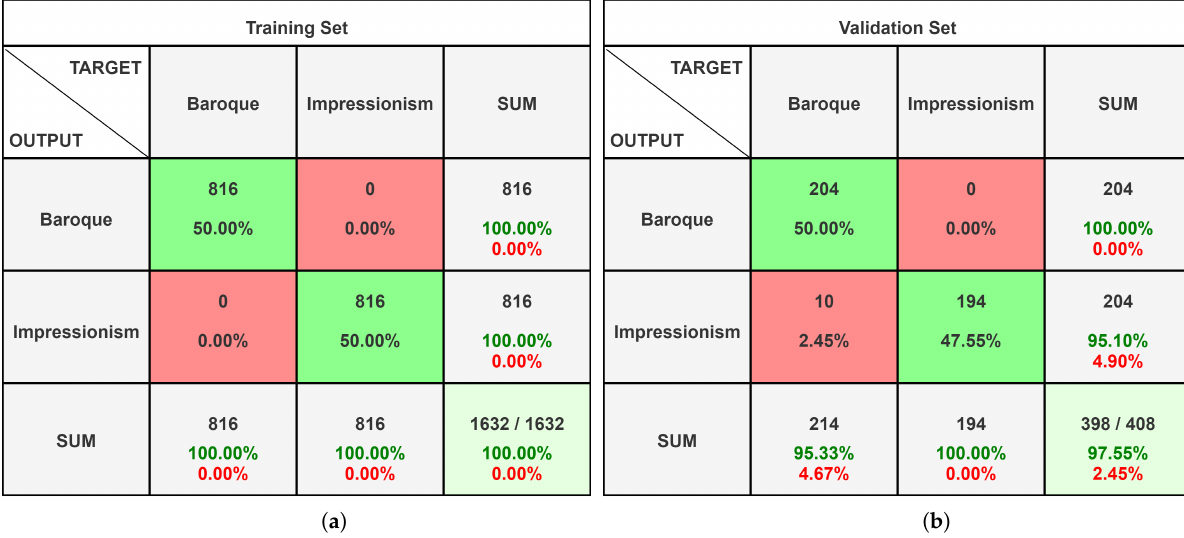
Figure 5. Confusion matrices of the painting dataset analysed on Alexnet with Matlab. ( a ) Training set confusion matrix; ( b ) validation set confusion matrix.